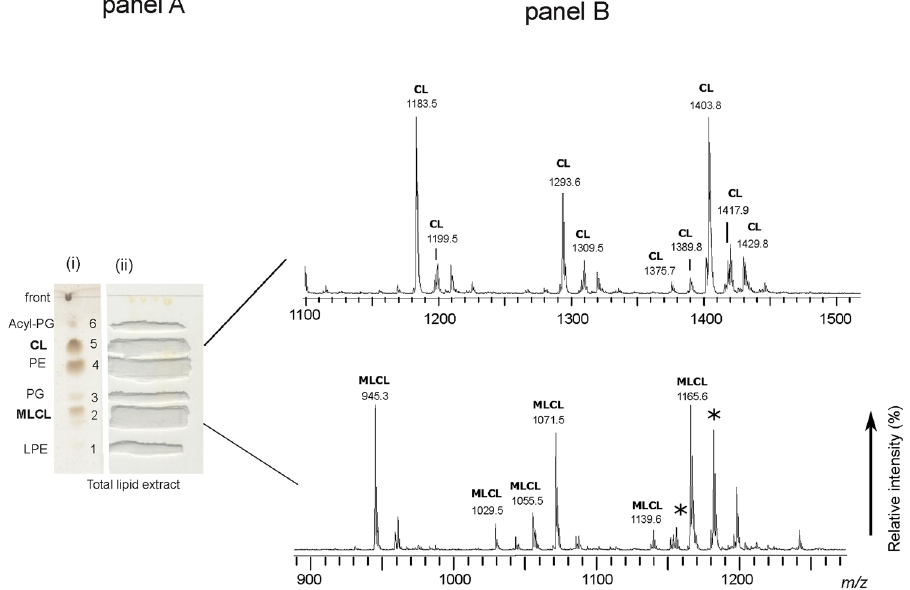
Figure 4. MALDI-TOF/MS analyses of lipid bands #2 and 5, isolated from the total lipid extract of A . baumannii by TLC. The chromatography plate is shown in panel A. Lipid bands #2 and 5 were extracted from silica and were analyzed by MALDI-TOF/MS. The MALDI/TOF-MS (negative ion mode) spectra of the two lipid bands corresponding to CLs (top), MLCLs (bottom) are shown in panel B. The detailed list of detected peaks is shown in Table 2. Peaks labeled with star have been attributed to TLC